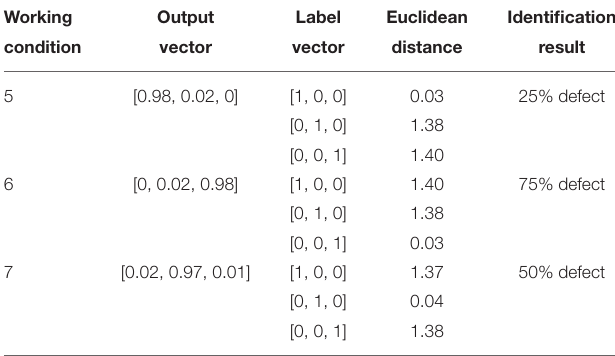
TABLE 5 | Euclidean distances between the output vectors and the sample labels.